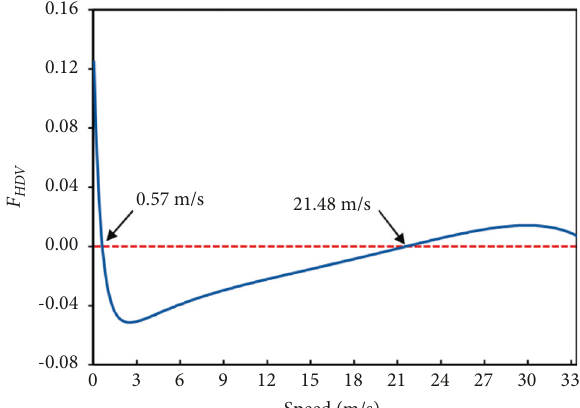
Figure 3: Stability values for HD vehicles with different equilib- rium